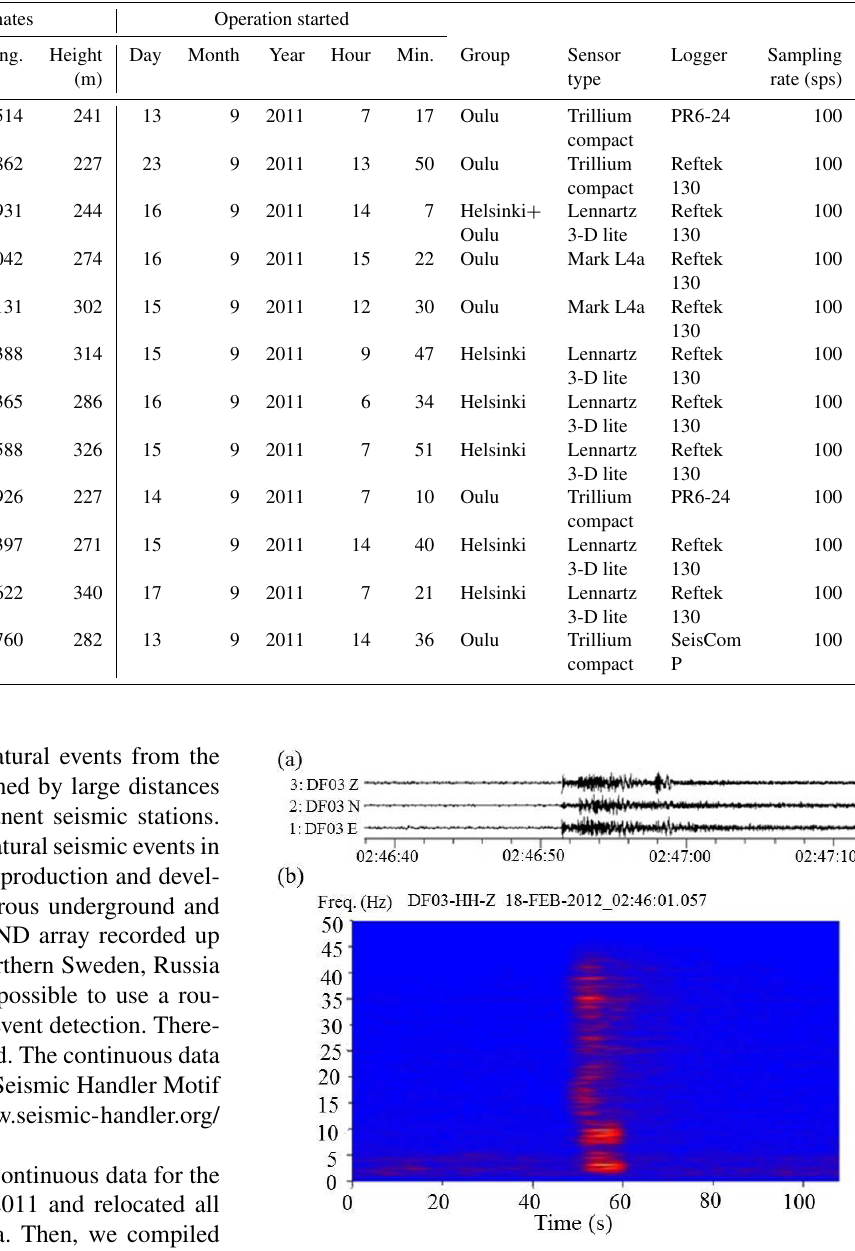
Figure 4. (a) An example of waveforms of production blast in Kit- tilä Mine recorded by DF03 station. (b) An example of a spectro- gram of the same